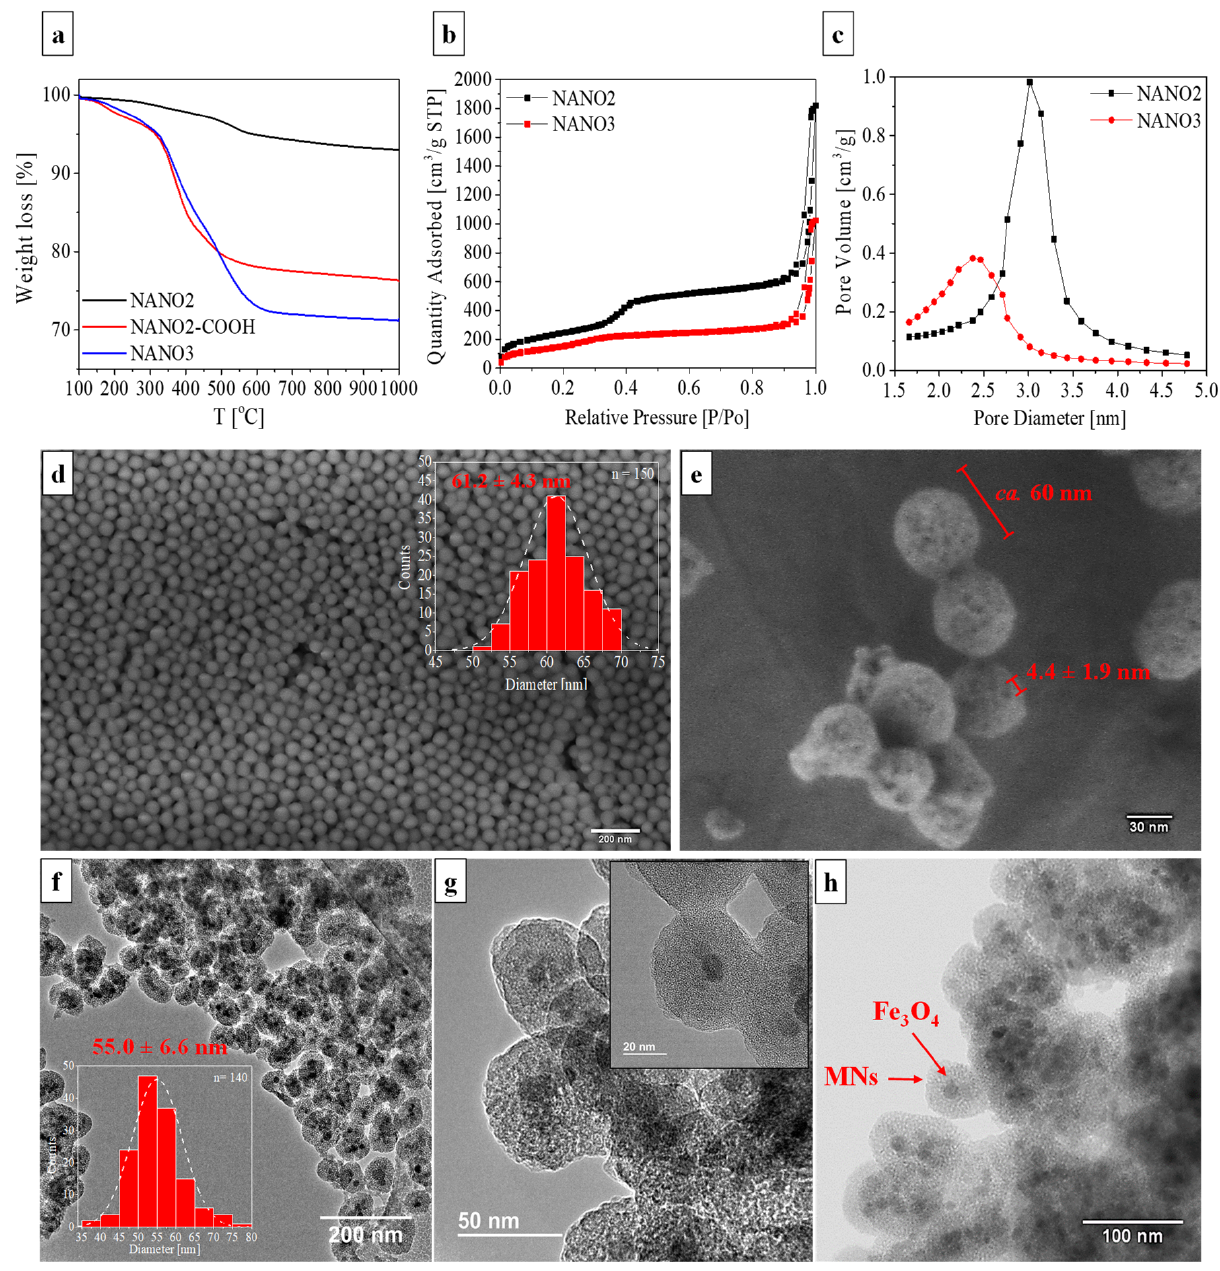
Figure 2. TGA weight loss curves for NANO2, NANO2-COOH and NANO3 (m i = 5.0 mg) ( a ). N 2 -isotherms ( b ) and pore size distribution ( c ) of NANO2 and NANO3. SEM micrograph of NANO2-COOH, inset: particle size distribution ( d ) and HRFESEM picture of NANO3, with distinguishable spherical shape and porosity ( e ). TEM images of NANO3, inset: particle size distribution ( f , g ) and brightfield STEM image of NANO3 ( h ).